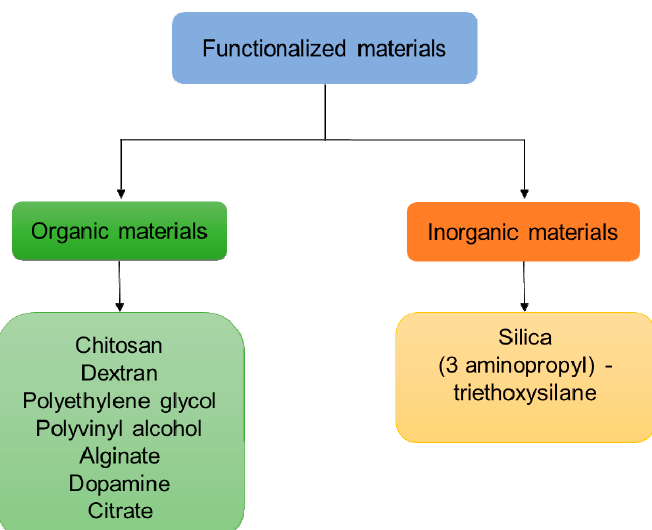
Figure 8. Flowchart of classification of organic and inorganic materials used for the functionalization of IONPs [51].